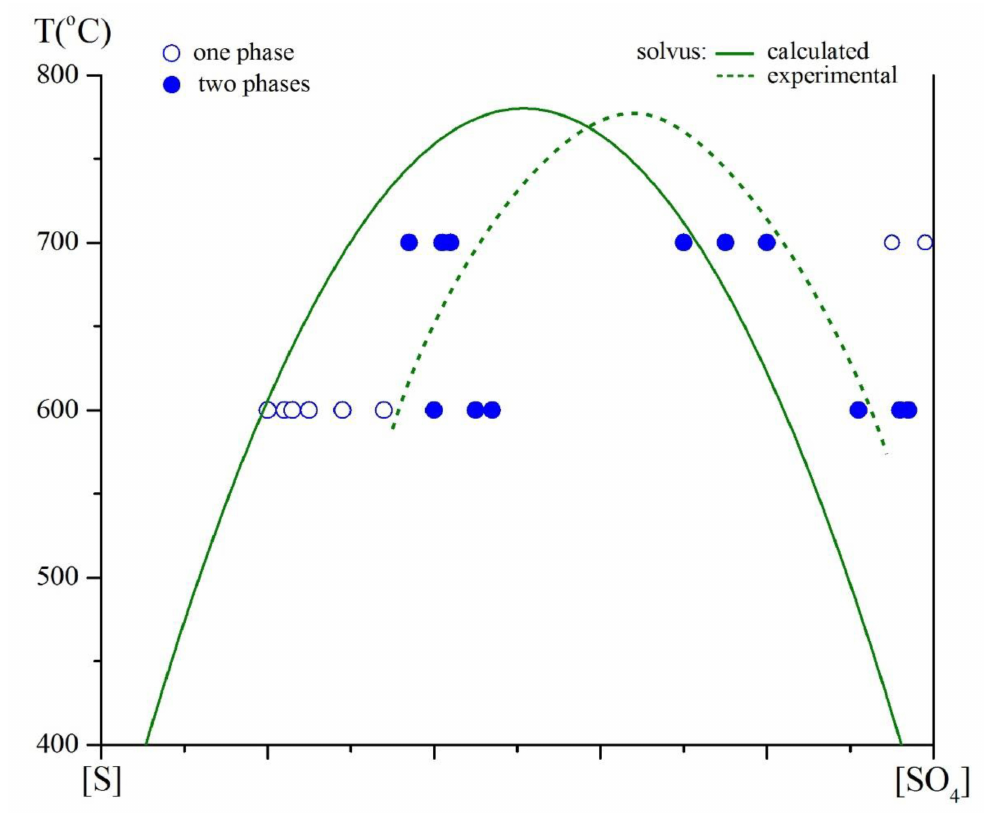
Figure 15. Calculated miscibility diagram in the Ca-bearing S-sodalite–haüyne system and experi- mental